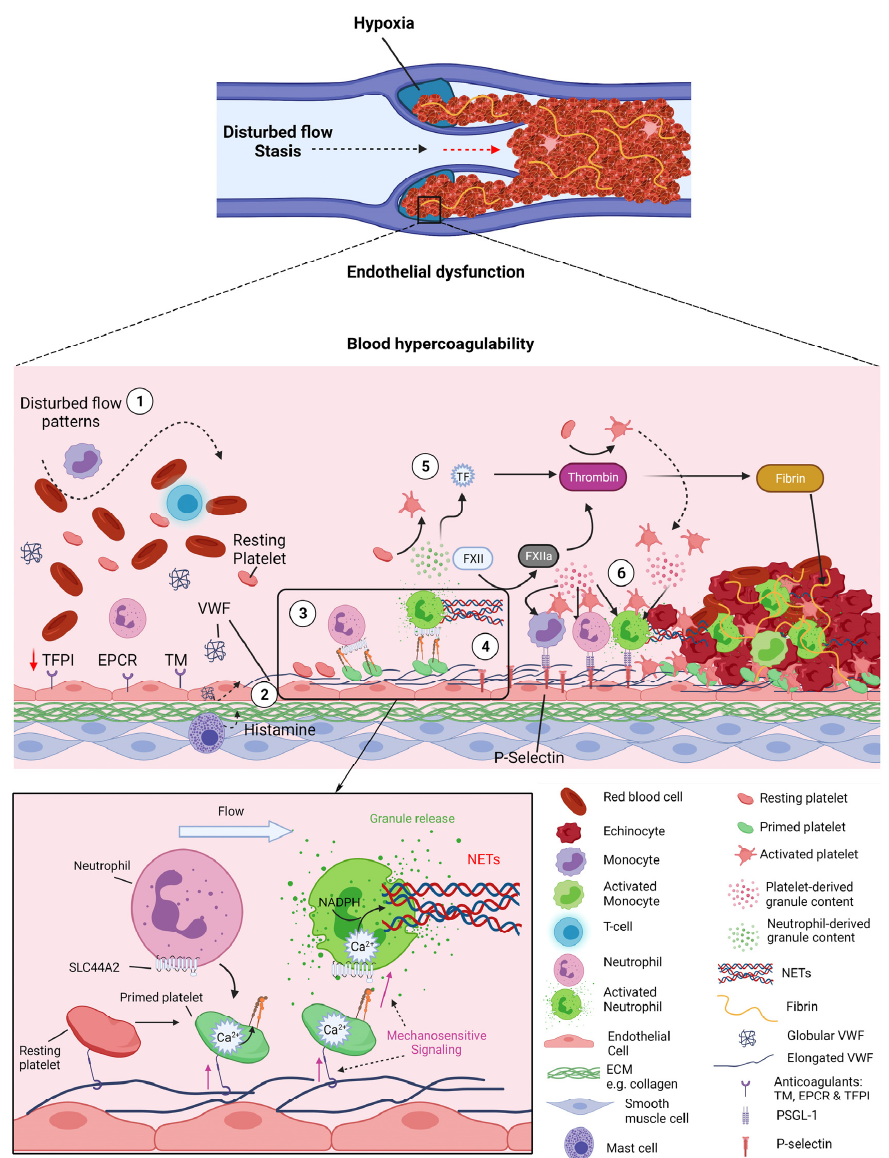
Figure 3. Platelet–neutrophil crosstalk in venous thrombosis. Venous thrombosis initiates in the pockets of venous valves where disturbed flow creates a prothrombotic environment: hypoxia, endothelial dysfunction and blood hypercoagulability. 1- These flow patterns/stasis induces downregulation of antithrombotic factors of the endothelium thrombomodulin (TM), endothelial protein C receptor (EPCR) and tissue factor pathway inhibitor (TFPI) and concomitant upregula- tion of procoagulant proteins von Willebrand Factor (VWF), P-selectin and other cell adhesion molecules. Mast cells are also thought to be involved in this process by releasing histamine. 2- Under these flow disturbance and pro-coagulant conditions, VWF can become tangled and un- ravel, exposing its A1 domain enabling platelet binding via GPIb α . 3- The VWF-GPIb α interaction under flow induces the mechano-unfolding of the mechanosensitive domain of GPIb α leading to signalling events, Ca 2+ release from intracellular stores and activation of α IIb β 3 . 4- Primed platelets via activated α IIb β 3 can bind SLC44A2 on neutrophils under flow. Shear forces in the neutrophil